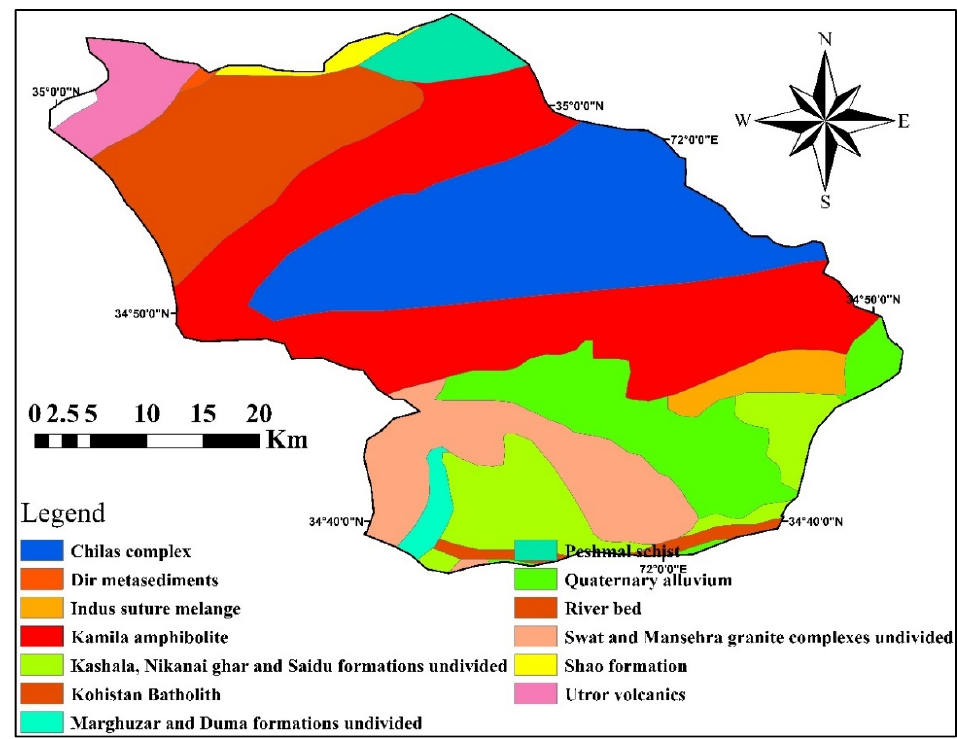
Figure 2. The identified geological formations in the Adenzai flood plain region of Pakistan.